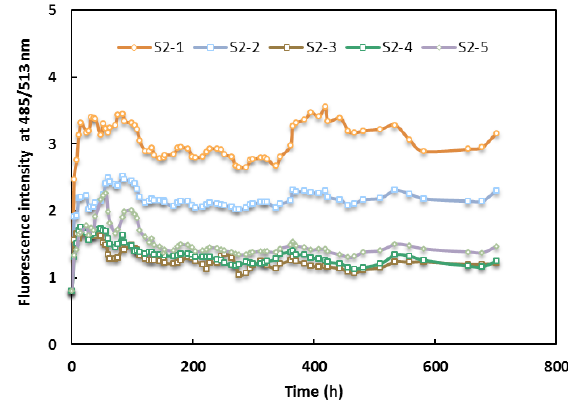
Figure 7: Fluorescence intensity in wells S2-1 and S2-5.